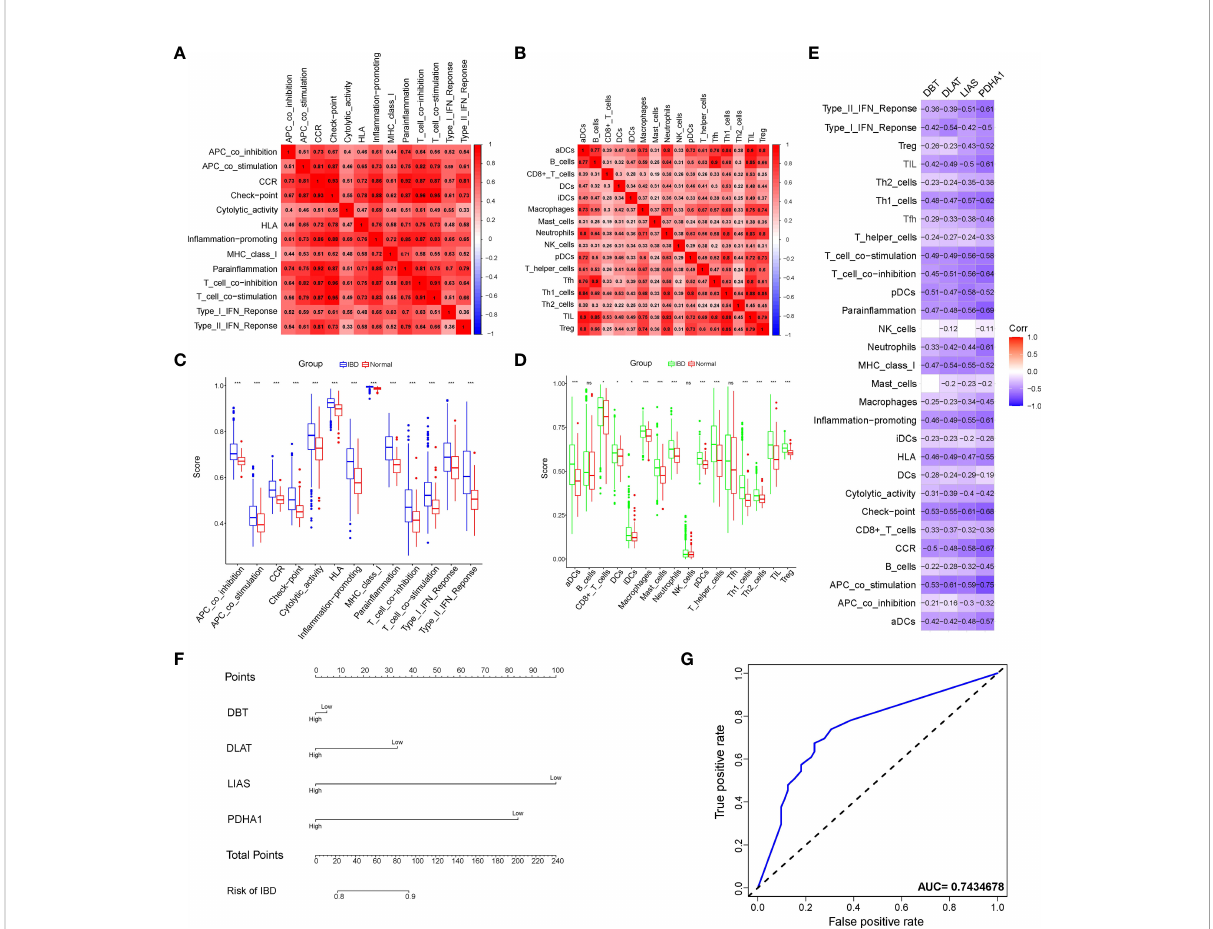
FIGURE 3 Analysis of immune cell components and diagnostic value of immune-related cuproptosis genes in IBD. (A, B) Correlation heatmap of immune components enrichment scores representing both immune cells and immune functions. (C, D) Violin plot of differentially immune-in fi ltrated fraction comparison between IBD and normal control. Asterisks indicate signi fi cances: ns no-signi fi cance, *p ≤ 0.05, ***p ≤ 0.001. (E) Correlation heatmap of the overlapping genes and the immune components. (F) Nomogram to predict the diagnostic value of the immune- related cuproptosis genes for IBD. (G) ROC curve of the contribution of expression pro fi le regarding immune-related cuproptosis genes to the prediction of